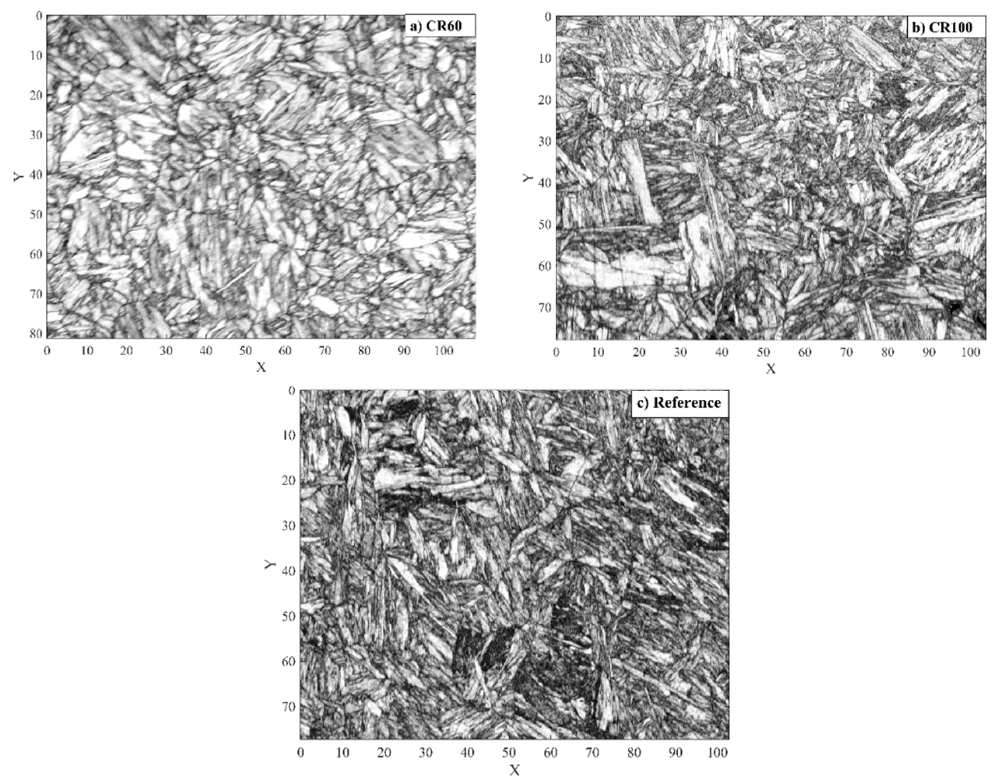
Figure 1. The band contrast images from the EBSD analysis for ( a ) CR60; ( b ) CR100 and ( c ) the reference sample in rolling direction with the axis showing size in μ m.